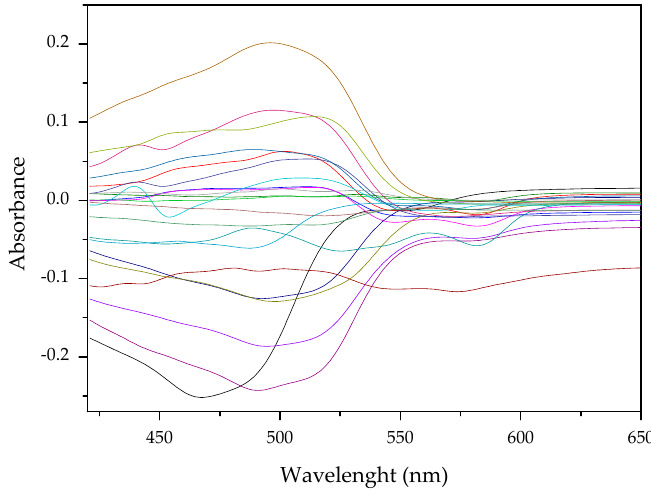
Figure 8. Visible spectra after algebraic transformation for the system PAN–Cd(II).